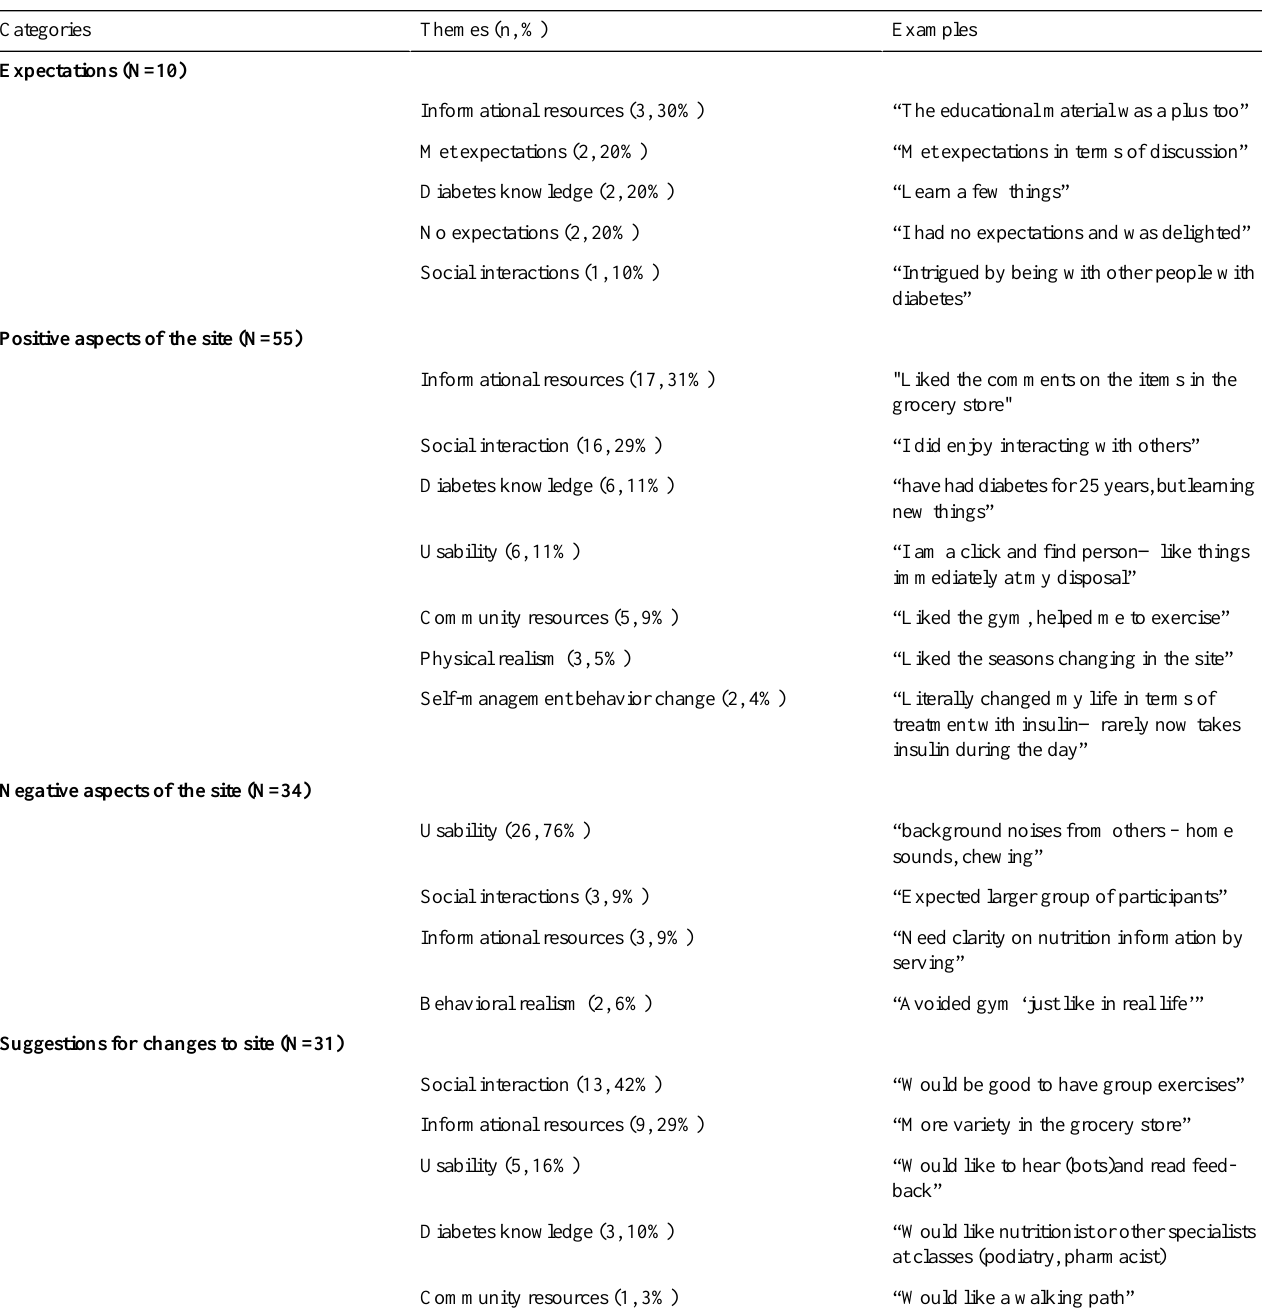
Table 3. Focus group